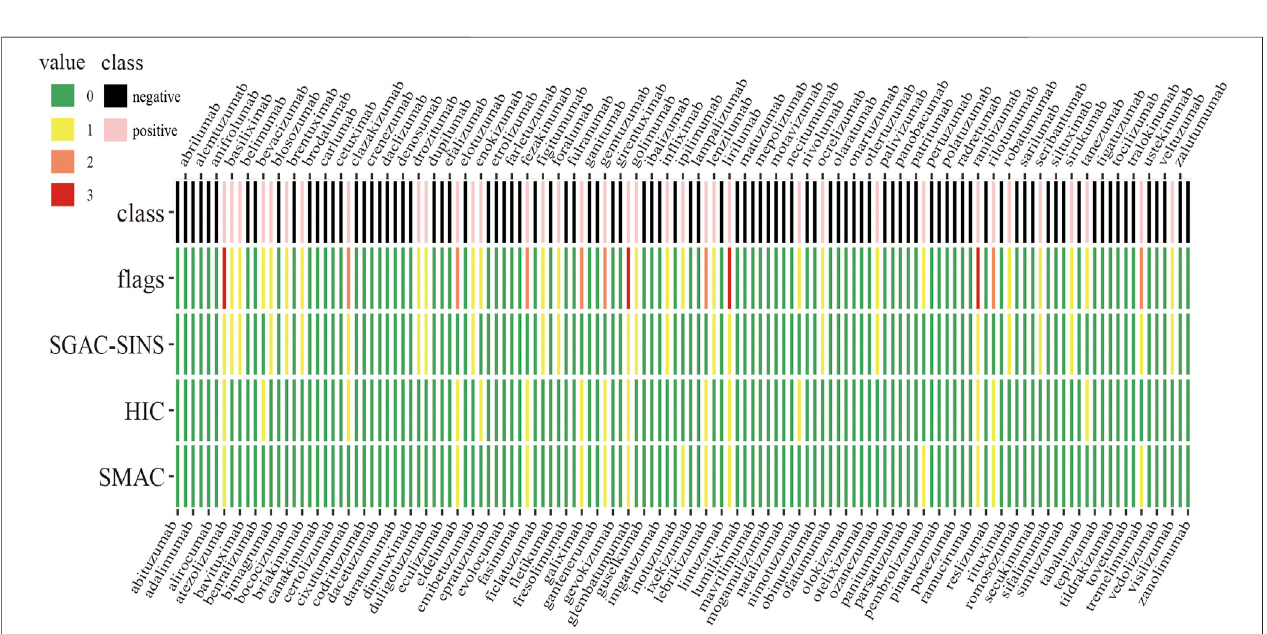
FIGURE 1 | The number of hydrophobic interaction fl ags and the classi fi cation of